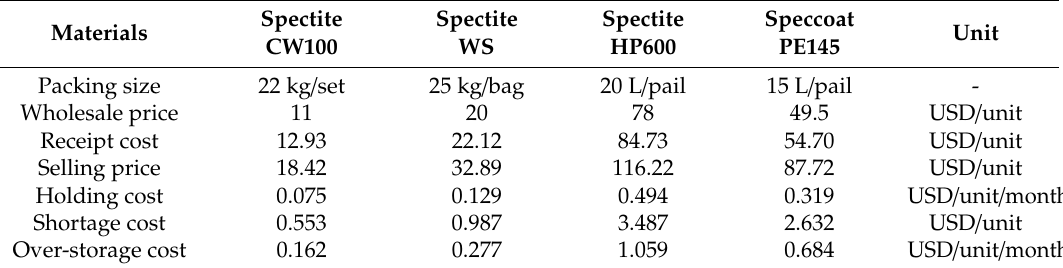
Table 3. Component costs of